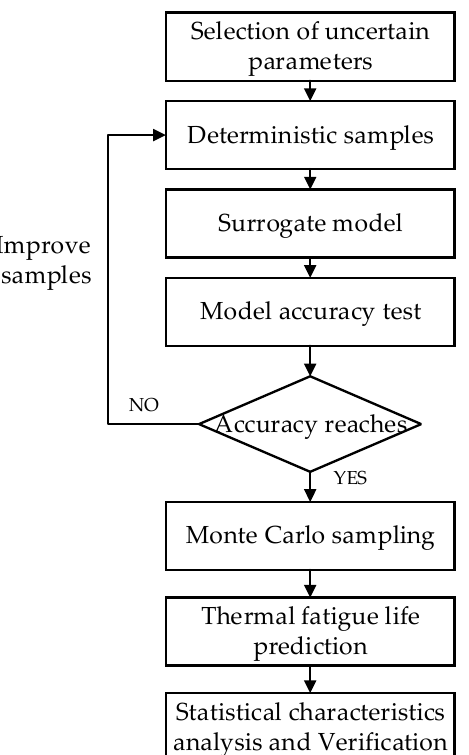
Figure 1. Flow chart of uncertainty analysis of thermal fatigue life prediction.